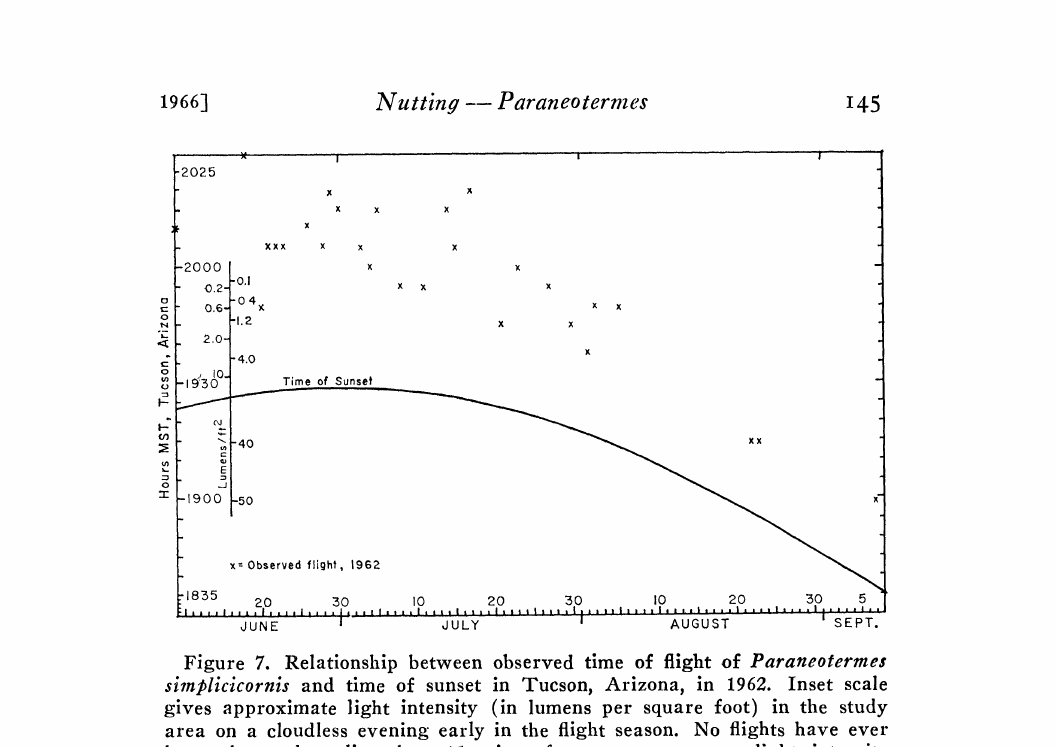
Figure 7. Relationship between observed time of flight of Paraneotermes sinplicicornis and time of sunset in Tucson, Arizona, in 1962. Inset scale gives approximate light intensity (in lumens per square foot) in the study area on a cloudless evening early in the flight season. No flights have ever been observed earlier than 15 min. after sunset or at a light intensity greater than approximately 0.5 lumen per square